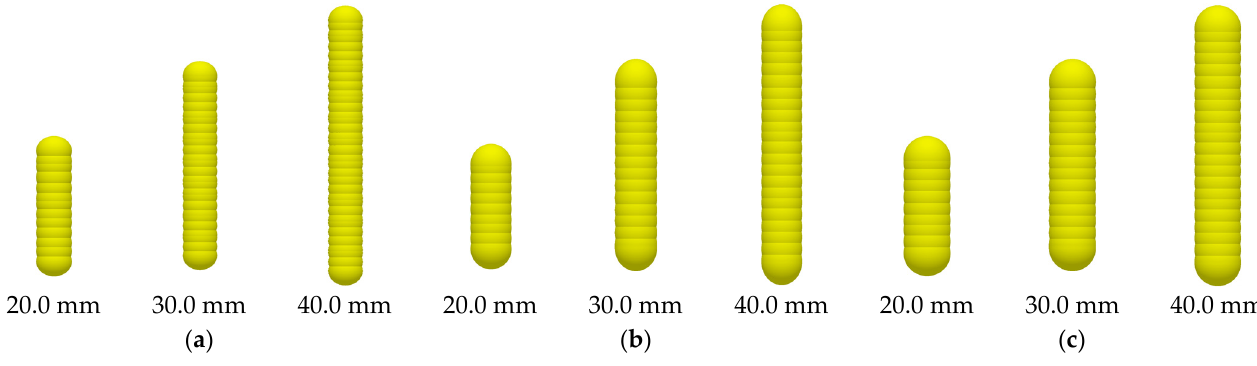
Figure 6. Rape stem repose angle test. ( a ) Diameter = 6.0 mm; ( b ) Diameter = 7.0 mm; ( c ) Diameter = 4.0 mm.